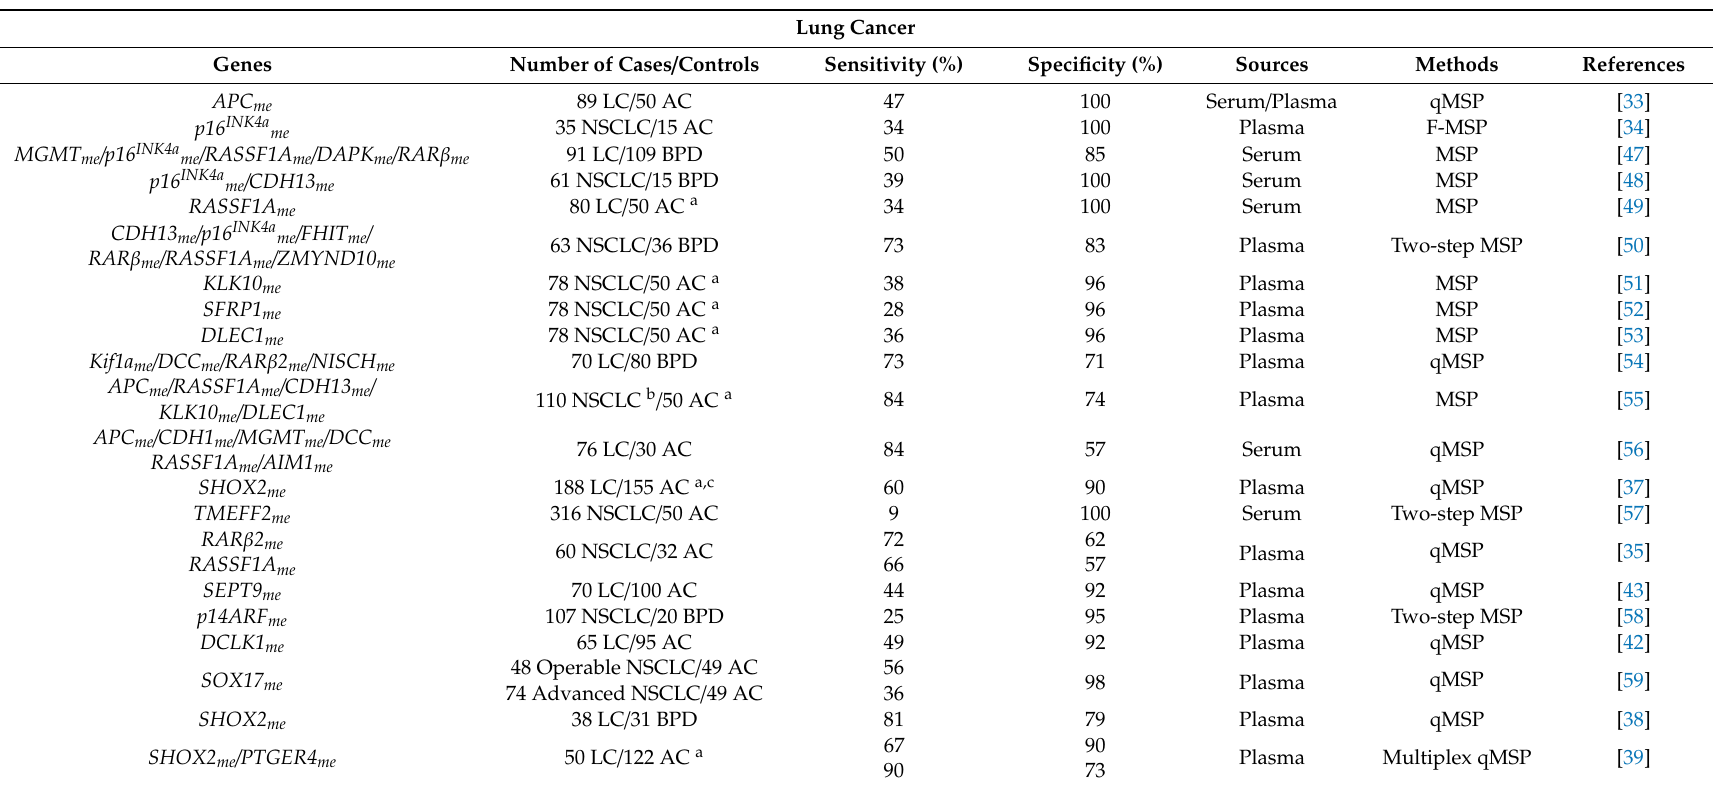
Table 1. CcfDNA-based methylation biomarkers for lung cancer (LC)